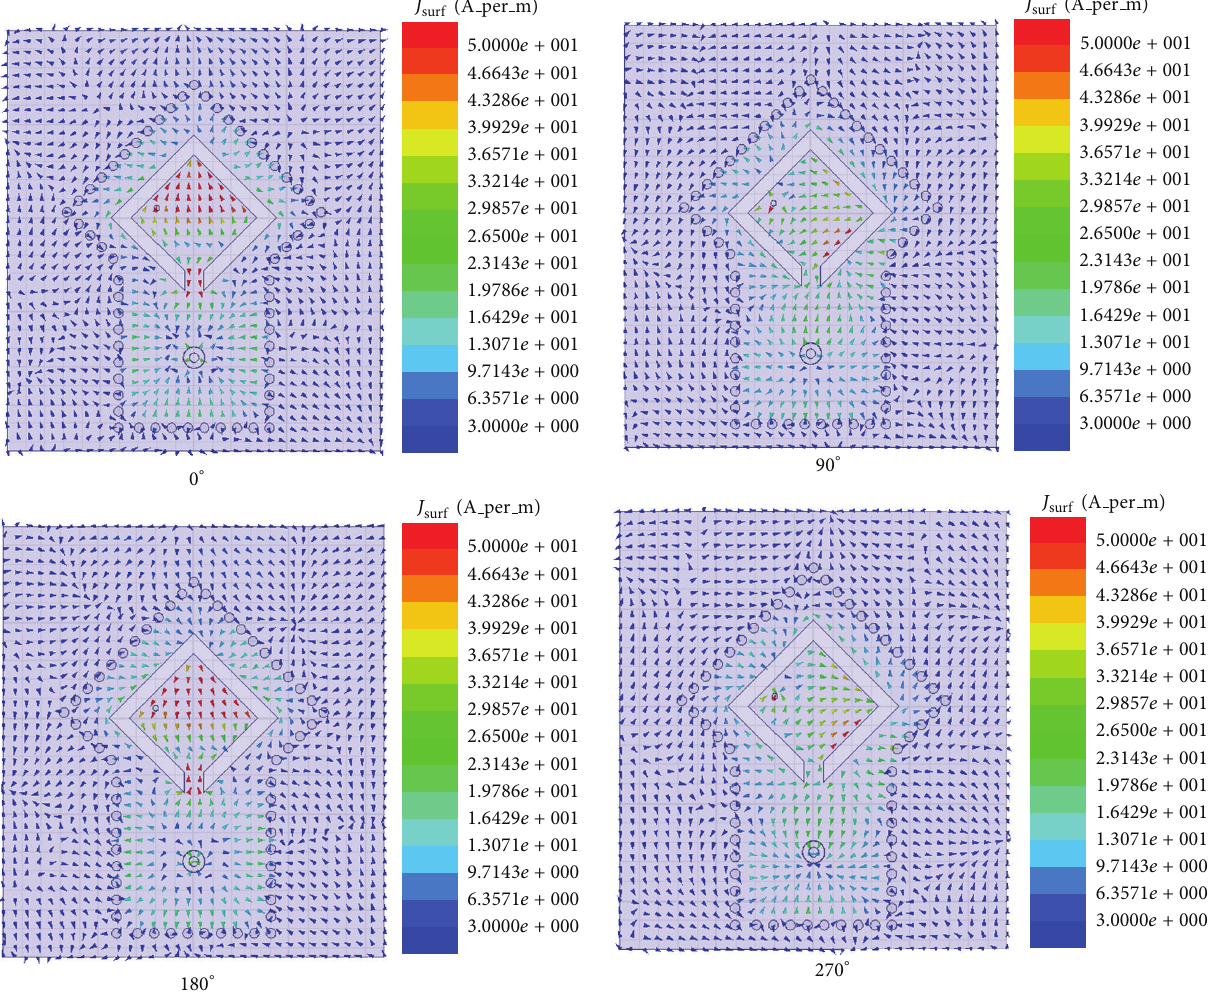
Figure 5: Distribution of the vector surface current on the diamond ring-slot of the proposed antenna at 10.3 GHz in 0 ∘ , 90 ∘ , 180 ∘ , and 270 ∘